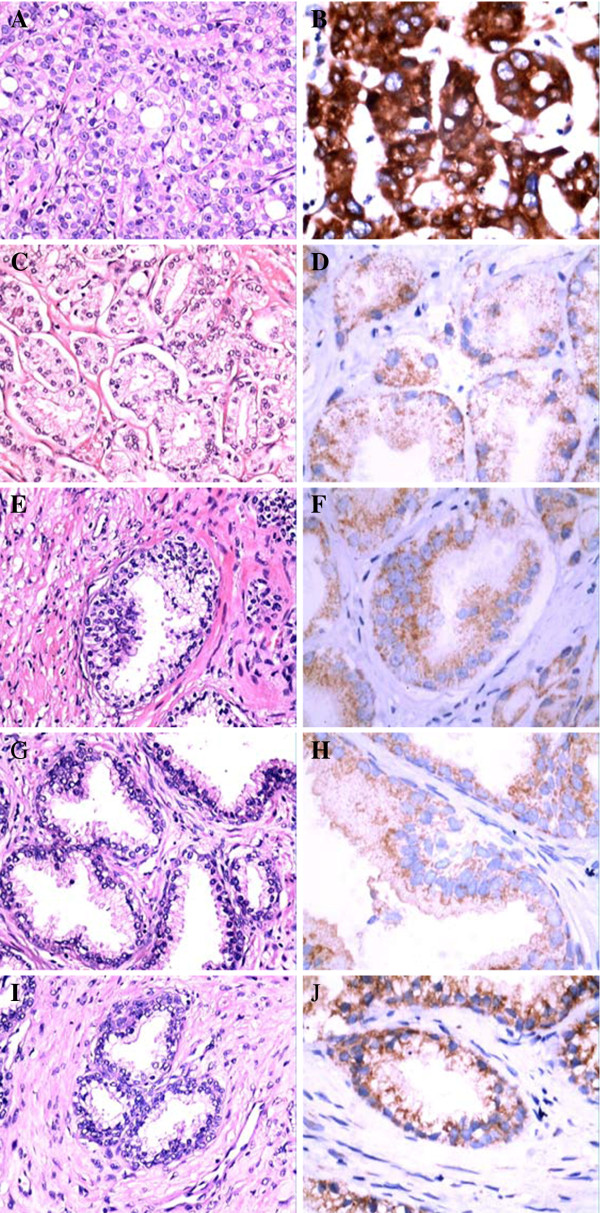
Representative H&E and immunohistochemical staining results for GOLPH3 (HE x200, IHC x400). A CRPC, H&E staining. B CRPC, GOLPH3(+++), IHC staining; C HDPC, H&E staining. D HDPC, GOLPH3(+), IHC staining; E HGPIN, H&E staining. F HGPIN, GOLPH3(+), IHC staining; G BPH, H&E staining. H BPH, GOLPH3(+), IHC staining; I Normal prostate tissue, H&E staining. J Normal prostate tissue, GOLPH3(+), IHC staining.